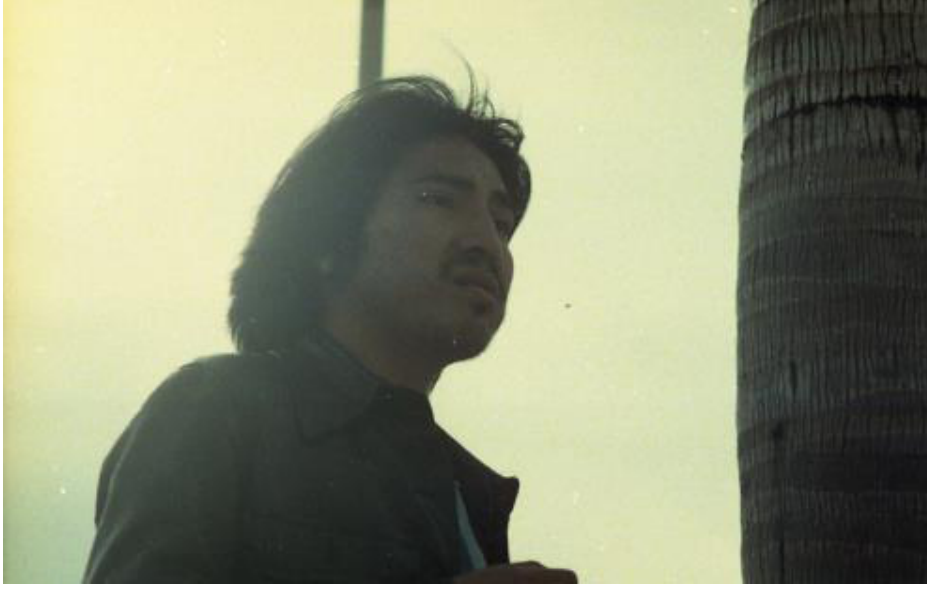
Figure 4 David Lamelas, The Desert People, 1974. Still of Manny ’s monologue . 16mm film transferred to DVD, color, sound, 44:09 min. Installation view. Hammer Museum, Los Angeles. Purchased through the Board of Overseers Acquisition Fund. Copyright David Lamelas, images courtesy of Maccarone, Sprüth Magers, and Jan